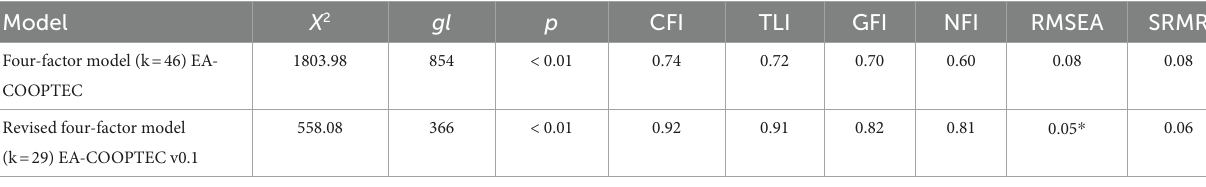
TABLE 3 Comparison between the fit parameters of the four-factor model of the EA-COOPTEC with 46 items and the revised four-factor model of the EA-COOPTEC v0.1 with 29 items.